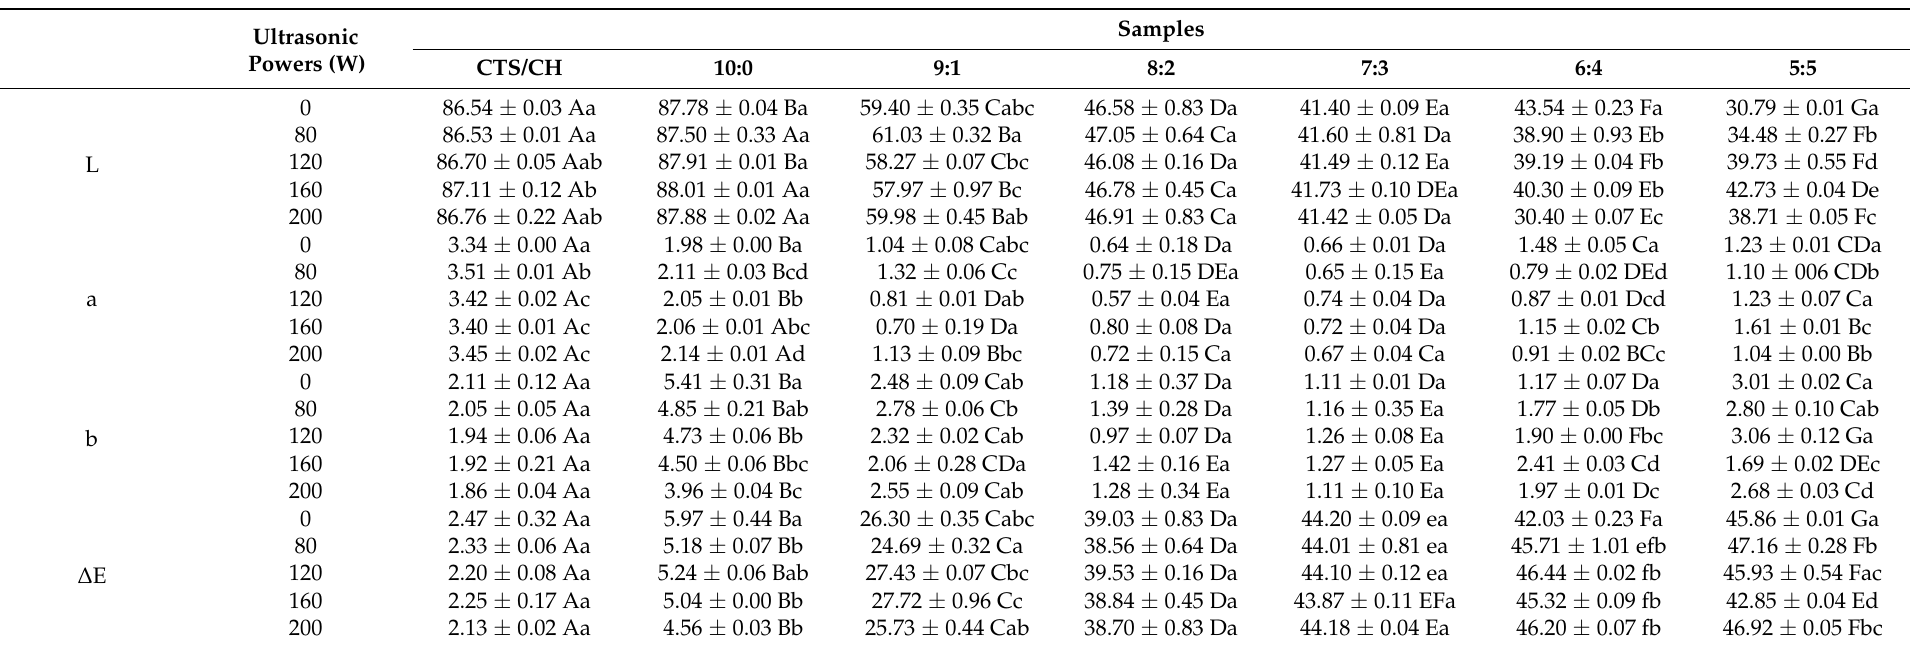
Table 3. Color of pure CTS/CH, CTS/CH/TiO 2 , and different CTS/CH/TiO 2 /Gr composite membranes under different ultrasonic